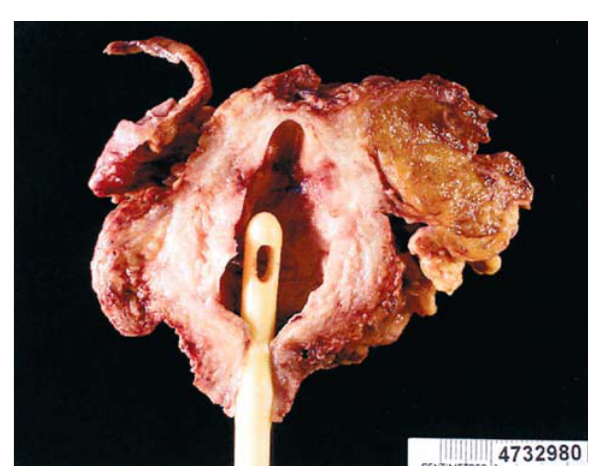
Figure 1 – Bladder specimen.